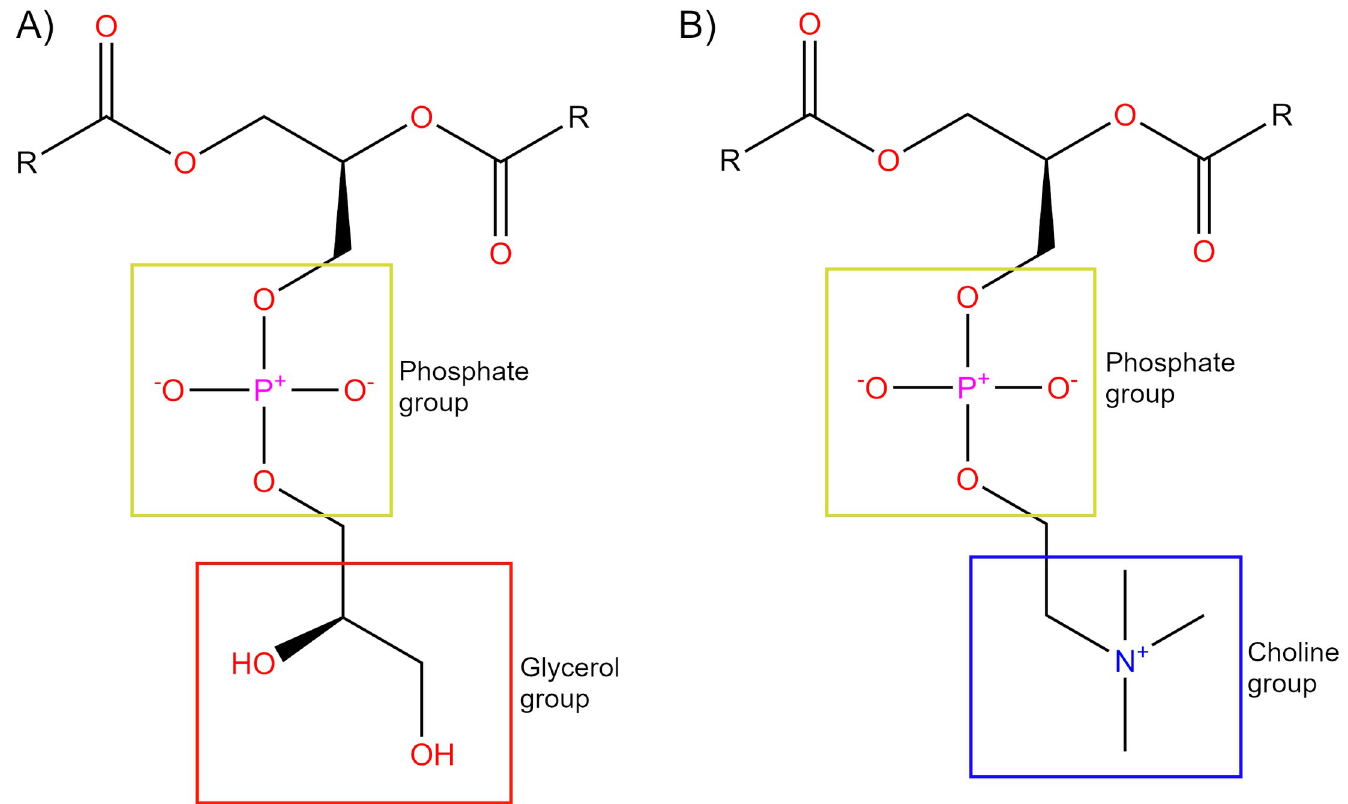
Fig 1. Structural comparison of DOPG and DOPC lipid headgroups. DOPG (A) headgroup is composed of a neutral glycerol group (red box) bound to the phosphate group (yellow box). DOPC (B) headgroup is composed of a positively-charged choline group bound (blue box) to the phosphate group (yellow box). DOPC and DOPG contain identical 18:1 fatty-acid chains